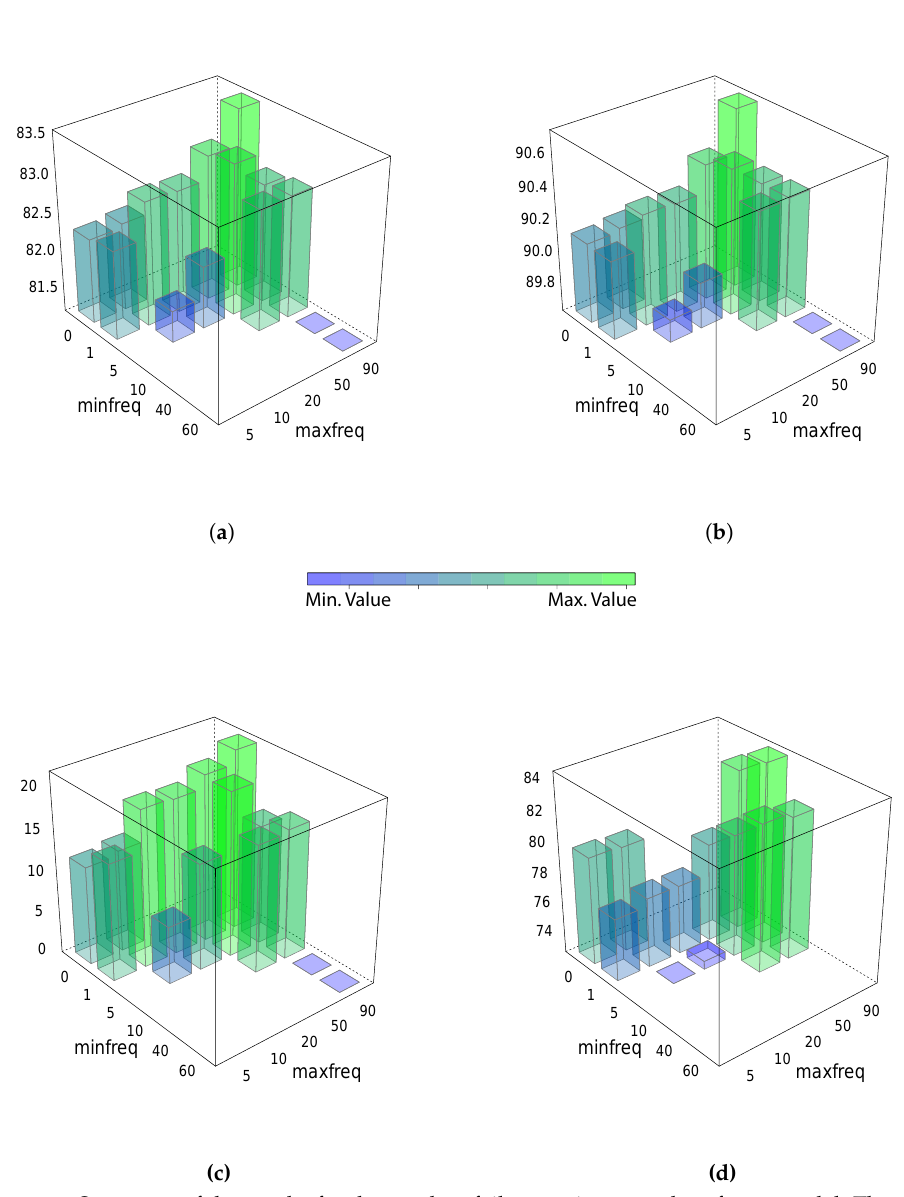
Figure 11. Summary of the results for the gearbox failures using a random forest model. The vertical axis indicates the minimal frequency % of a word in the training dataset in order to be selected by the model. The horizontal axis indicates the maximum frequency %. Each of the panels show a different metric for the same experiment; ( a ) shows the accuracy %, ( b ) the F-score in %, ( c ) the kappa in % and ( d ) indicates the AUC. Empty blocks (ranges) are values that cannot be calculated from a prediction with a unique class